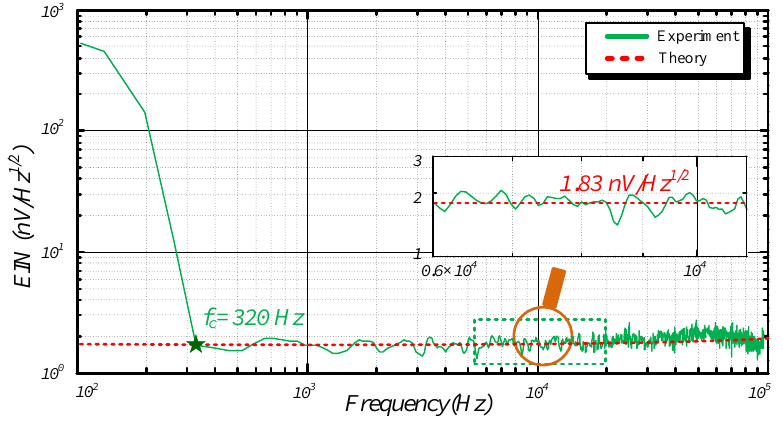
Figure 11. EIN of